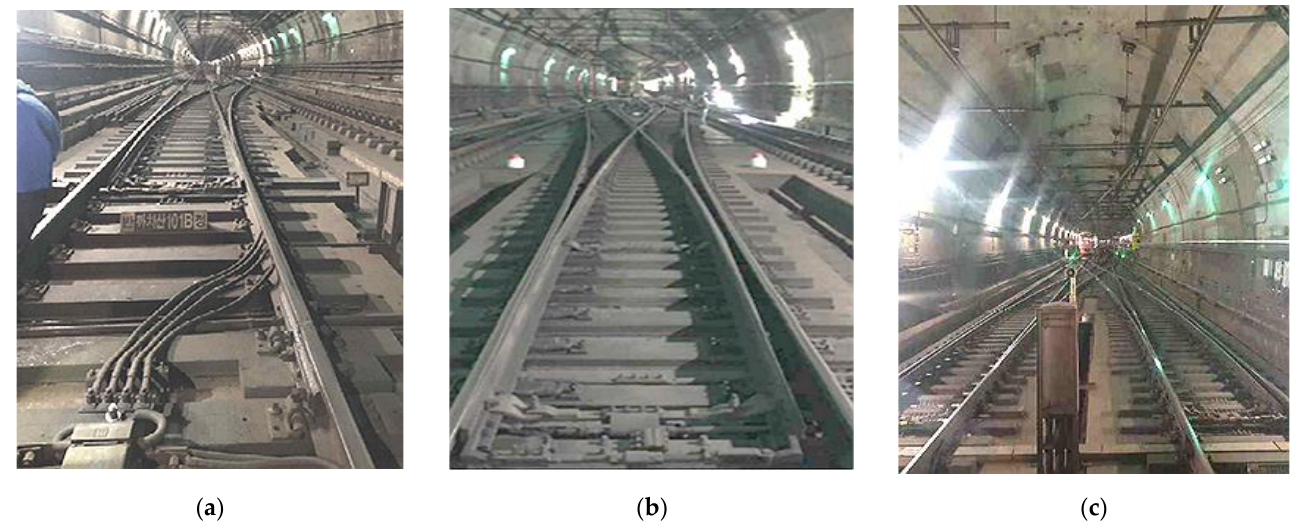
Figure 3. Types of turnout: ( a ) crossover; ( b ) double junction; and ( c ) scissors.